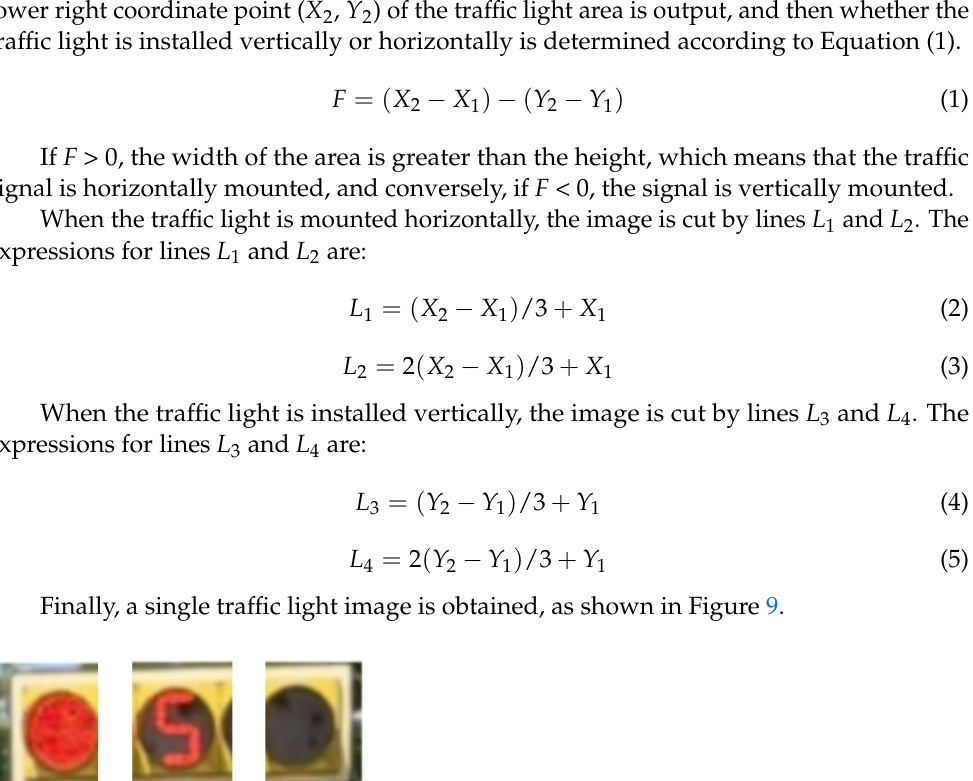
Figure 8. Vertical and horizontal installation of traffic light.